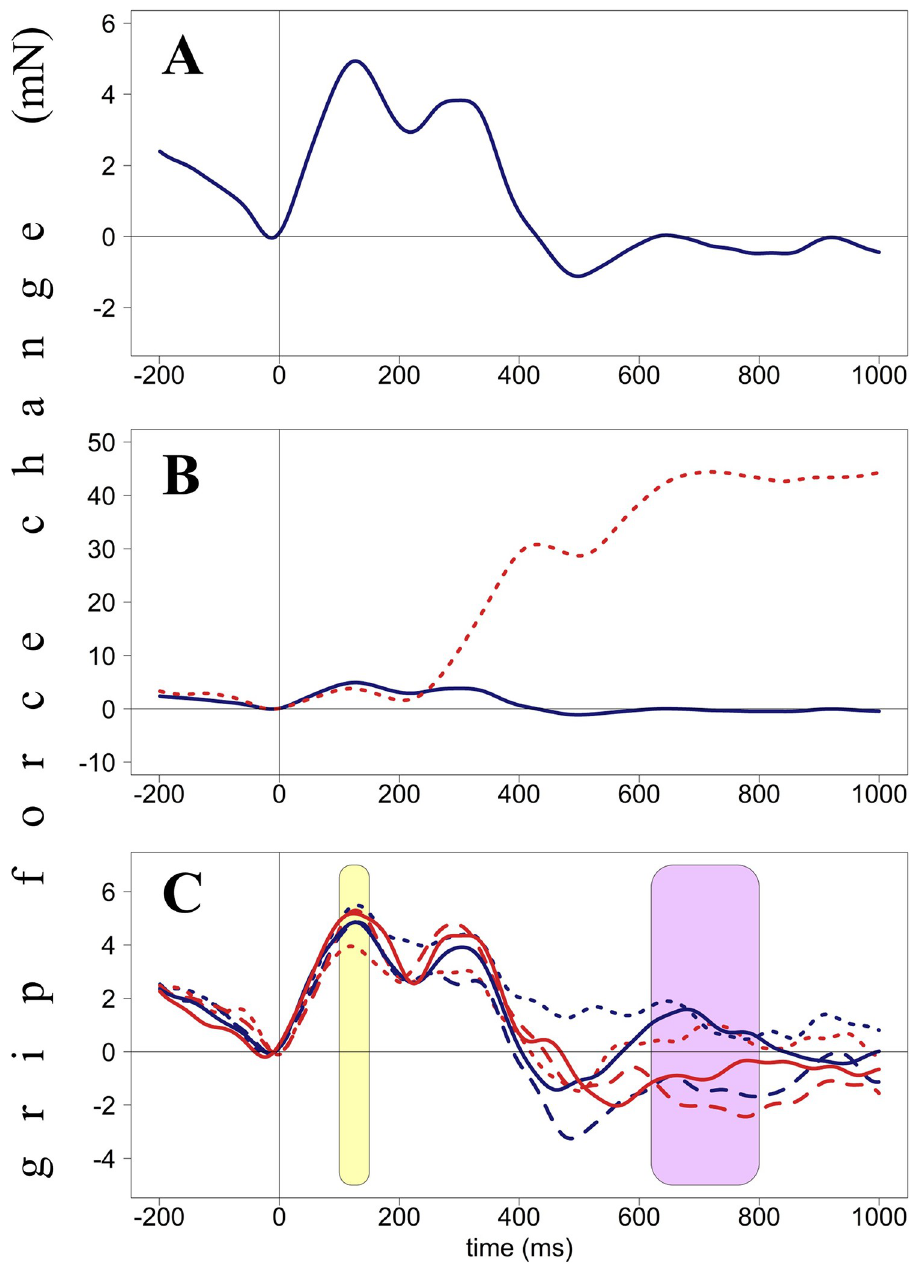
Fig 6. Grip force changes (in milli-Newton) plotted against time from stimulus onset (in milliseconds), Experiment 2. Panel A. Averaged force profiles across all accepted no-go trials of all participants. Panel B. Force profiles in go (dotted red line) and no-go (solid blue line) trials. These forces diverge around 250 ms after stimulus presentation. Panel C. Force profiles averaged by condition (Hand X Direction). Yellow area (100–150 ms) indicates interaction between Hand and Direction; violet area (620–800 ms) represents the main effect of Direction close to significance (p < .1). Red lines represent right-hand forces, blue lines–left-hand forces. Dotted lines represent the arrow-left condition, solid lines–arrow-in-both-directions, dashed